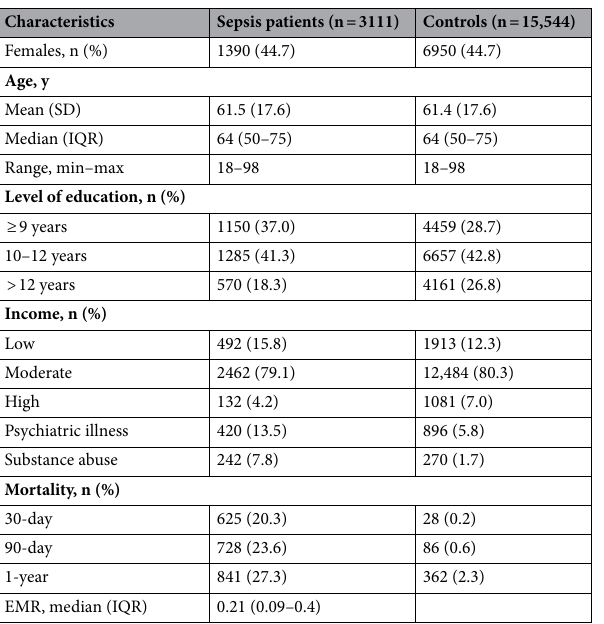
Table 2. Baseline characteristics of sepsis patients without somatic comorbidity at ICU admission and controls. ICU Intensive care unit, SD Standard deviation, EMR Estimated mortality